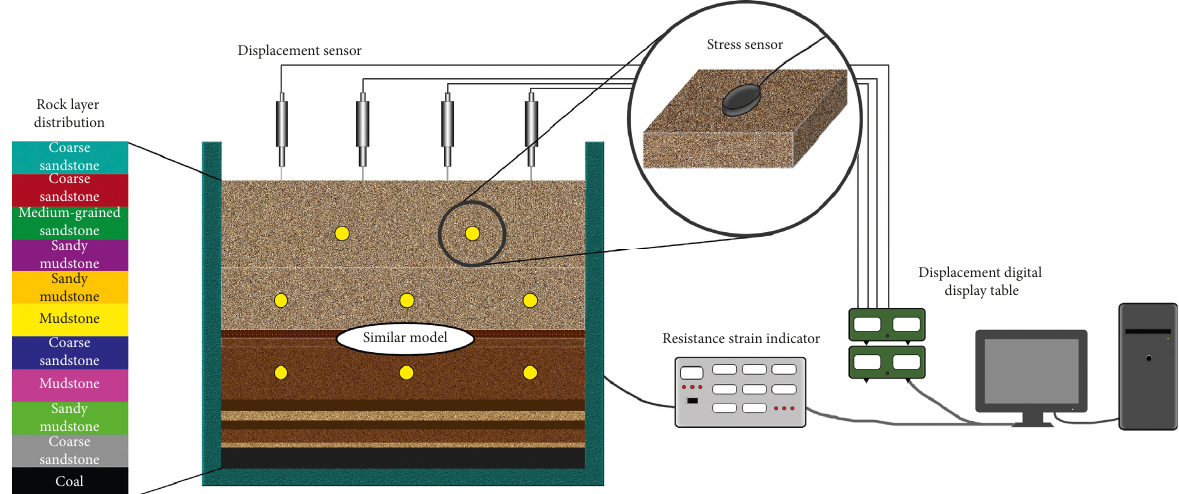
Figure 4: Similar model experiment test system.